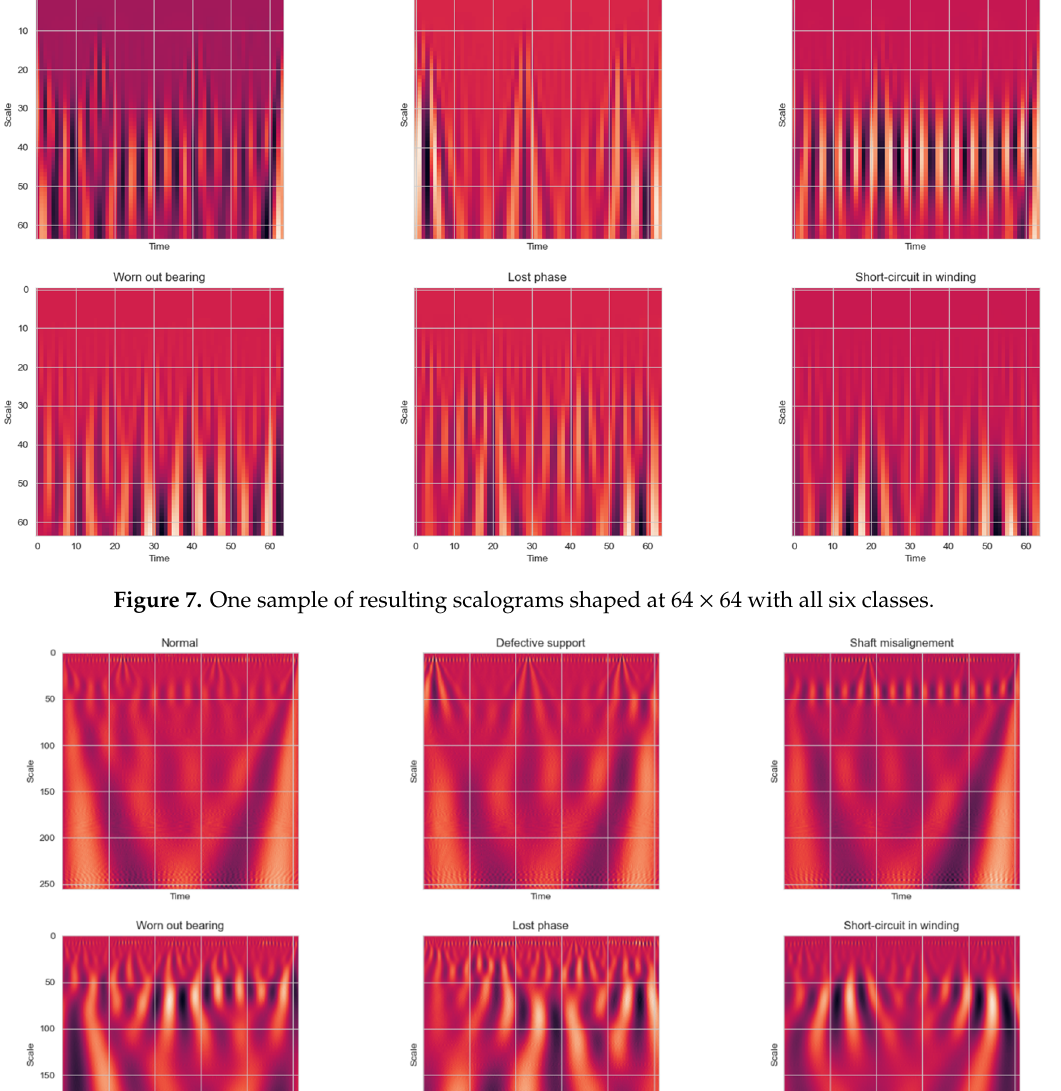
Figure 8. One sample of resulting scalograms shaped at 256 × 256 with all six classes.